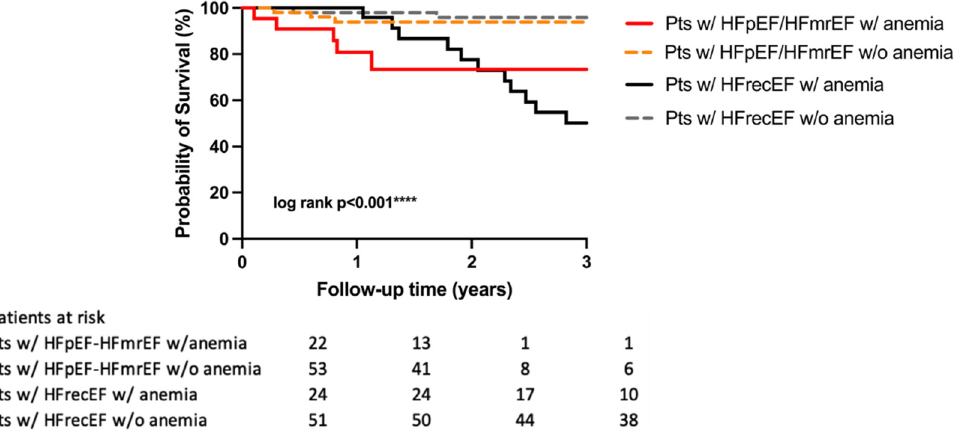
Figure 3. Kaplan–Meier estimates of the probability of survival in HFpEF–HFmrEF patients with and without anemia, HFrecEF patients with low and with normal serum hemoglobin levels. Table 4. All-cause mortality risk based on the type of heart failure and on the presence of anemia. All-Cause Mortality HR 95% CI p Value HFpEF-HFmrEF patients with anemia vs. 4.36 0.93/20.50 0.03 * HFpEF-HFmrEF patients with normal serum hemoglobin levels HFrecEF patients with anemia vs. HFrecEF patients with 9.64 3.44/27.00 <0.01 *** normal serum hemoglobin levels HFpEF-HFmrEF patients with anemia vs. HFrecEF patients 1.42 0.47/4.35 0.45 with anemia HFpEF-HFmrEF patients without anemia vs. HFrecEF pa- 1.55 0.33/7.24 0.48 tients without anemia